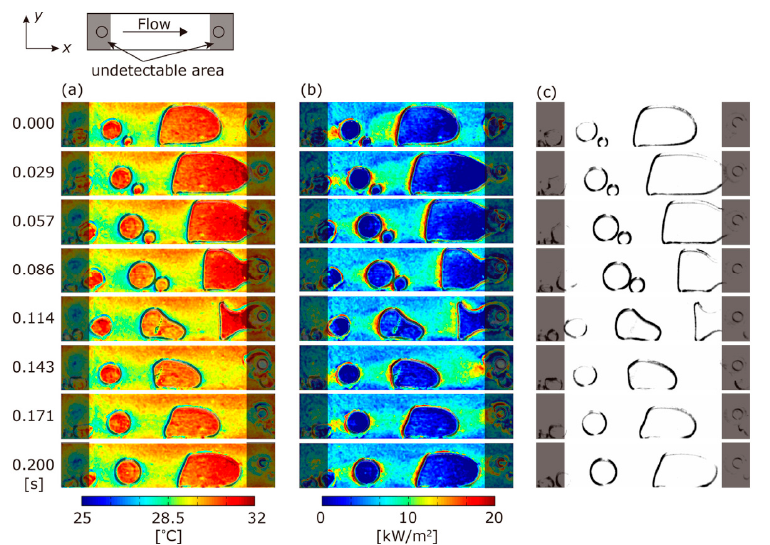
Figure 17. Images obtained by Matsuda et al. [107] with TSPs in FC-72 fluid boiling under upper temperature regulation (with a water channel at 40.4 °C). ( a ) Temperature distribution, ( b ) heat flux distribution, and ( c ) gas-liquid interfaces. Article published with open access.